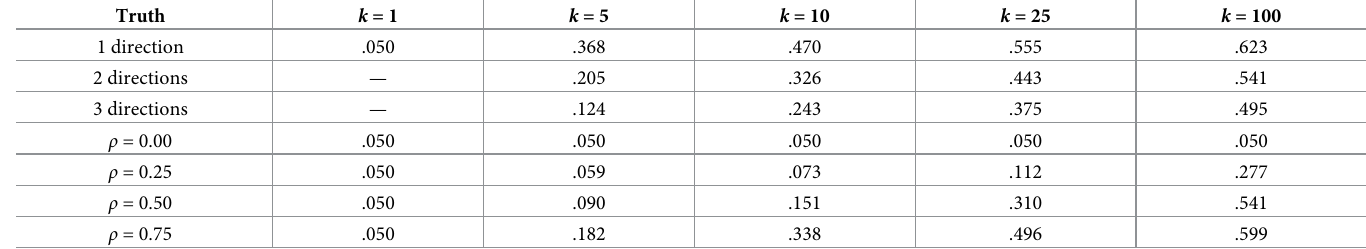
Table 1. Probability of suspecting fraud (that is, L 2 � C ) when C is determined assuming the Z i are independent. The true S either has all variability focused equally in 1, 2, or 3 directions, or each off-diagonal element has value ρ . Truth